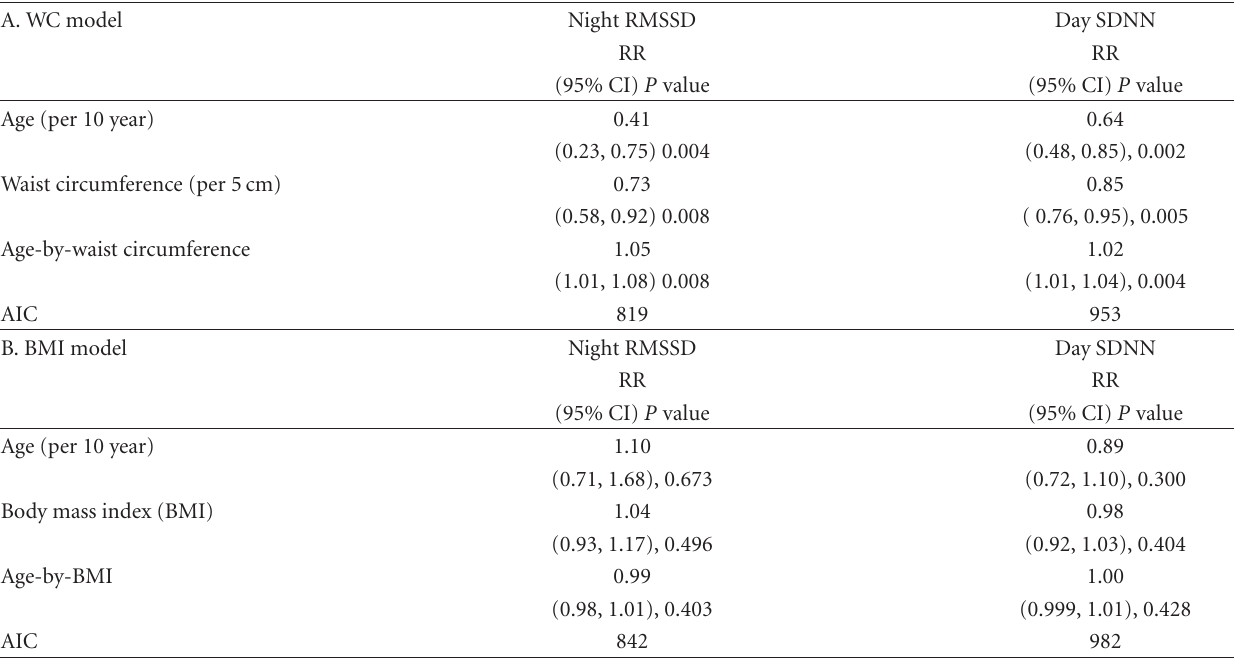
Table 2: Relative risks (RR) percent change in SDNN and RMSSD for each standard deviation increase in the obesity variables: waist circumference (WC) and body mass index (BMI). Smaller Akaike’s Information Criterion (AIC) indicates better fitted